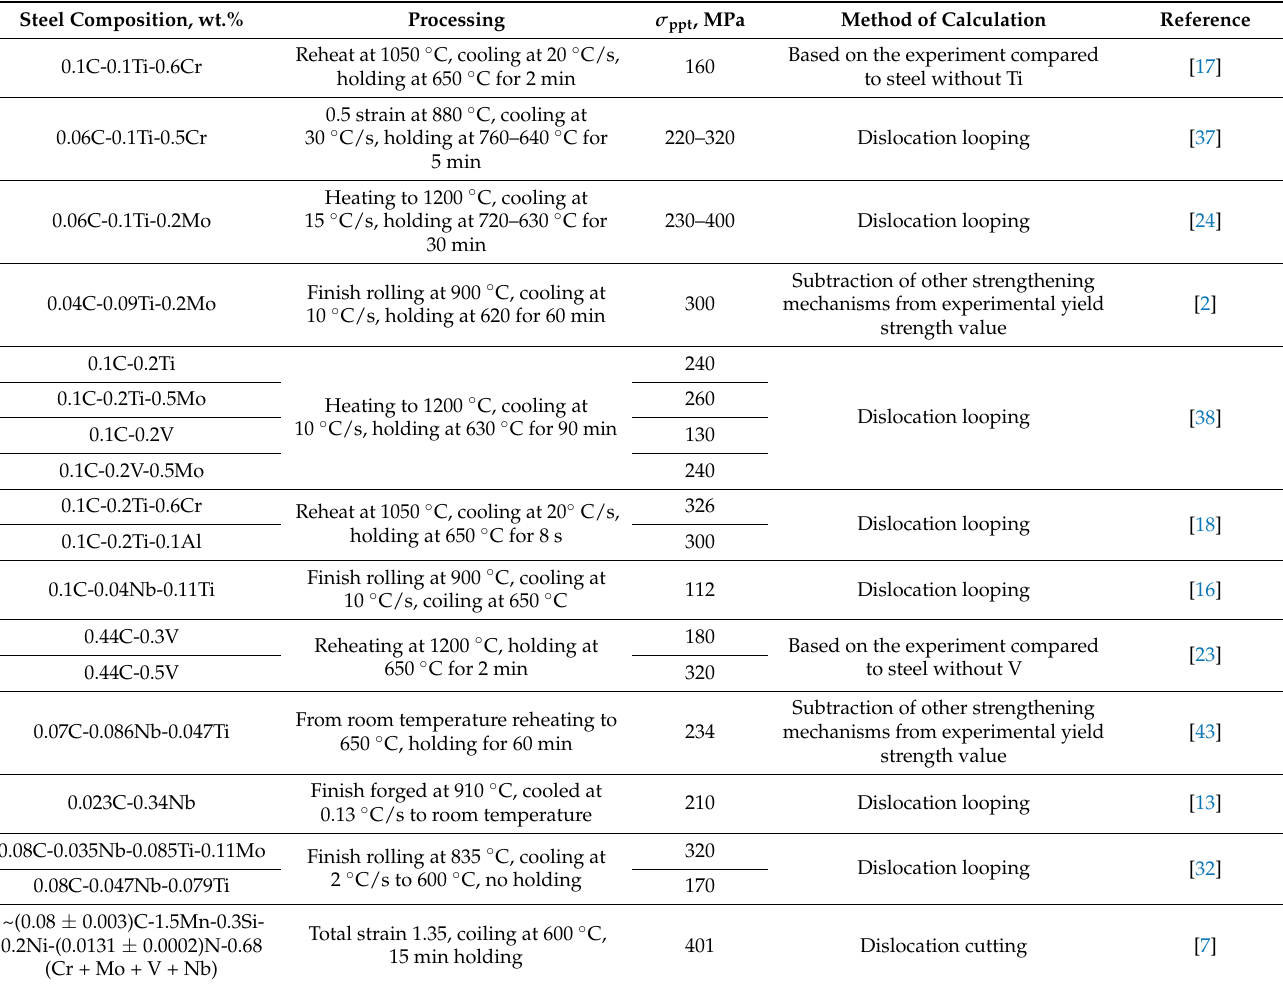
Table 1. Strengthening contribution from interphase precipitation (published